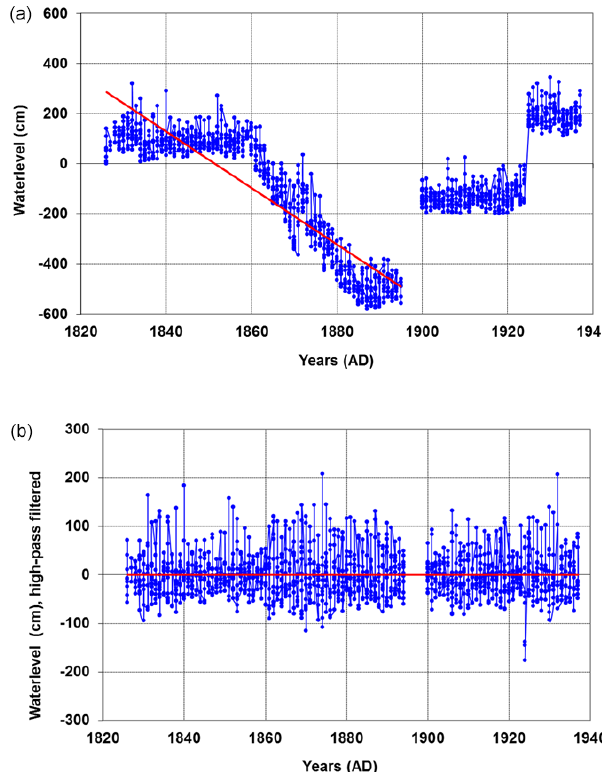
Figure 2. (a) , (b) : monthly maxima of water level (in cm) from 1826 to 1937 at the gauge Ettringen/Wertach (35km south of Augs- burg). (a) original data from official records and (b) high-pass- filtered